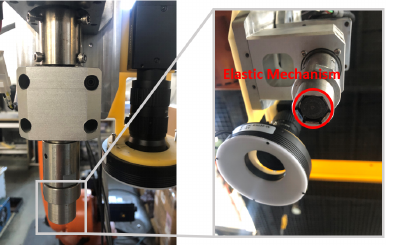
Figure 5. Servo unfastening tool with an elastic mechanism.